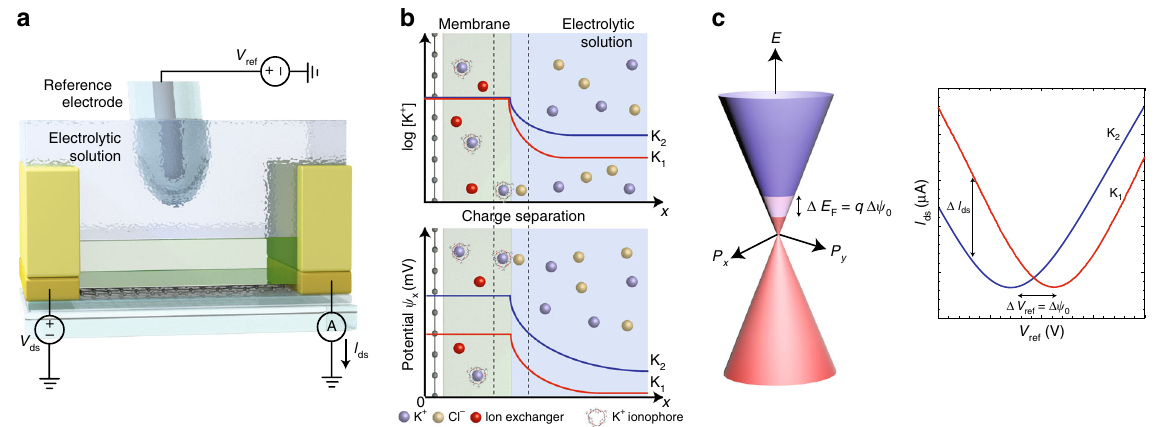
Fig. 2 Graphene ISFET sensing mechanism. a Electrical setup for measuring the current through the graphene channel I ds for different electrolytic solutions. I ds was monitored at a constant bias V ds , while the electrolytic potential was varied through the reference electrode V ref . b Mechanism of how changes in analyte concentration affects the ISFET surface potential. The concentration of the target ion is buffered to a constant, and a charge separation layer appears at the membrane/electrolyte interface. A potential difference appears across the interface due to the difference in ion concentration between the membrane and the bulk solution. c A change in surface potential leads to a direct shift in the graphene Fermi level and is translated to a shift in the ISFET transfer